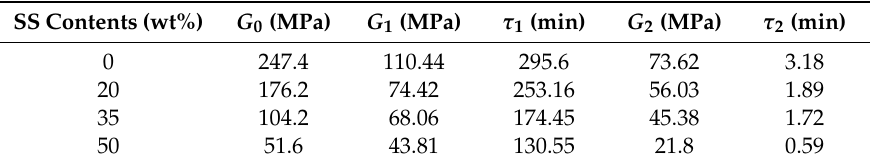
Table 2. Viscoelasticity parameters of sodium carboxymethyl cellulose (CMC) / styrene–butadiene rubber (SBR) with di ff erent carbon black